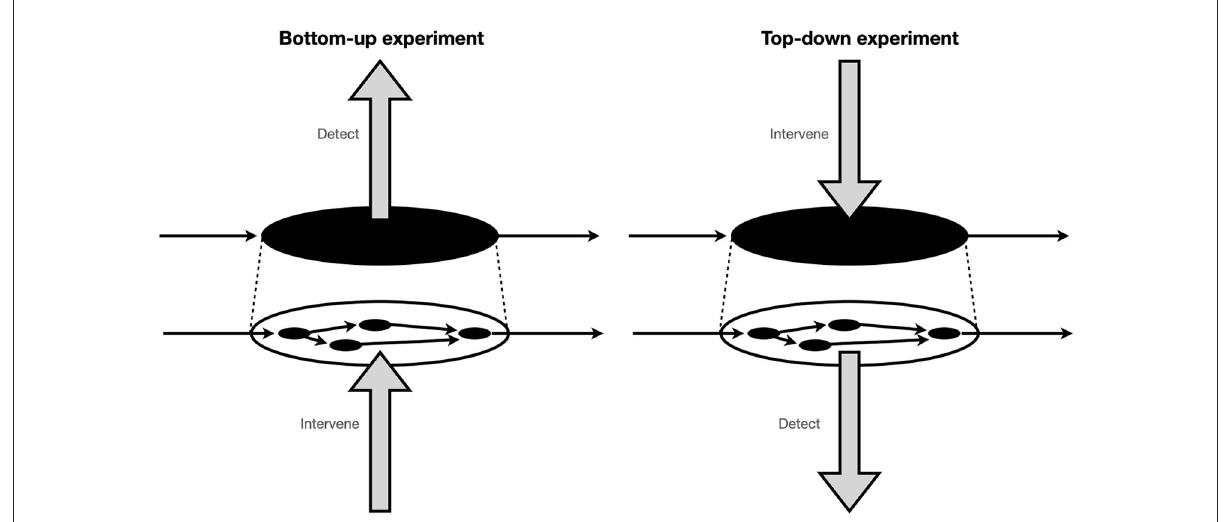
FIGURE1 Craver’s original diagram schematizing ideal “top-down” and “bottom-up” experimental interventions on a mechanism. Adapted from Craver (2007b, p. 146).